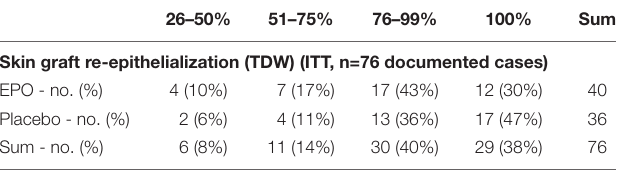
TABLE 7 | Analysis of secondary outcome: TDW